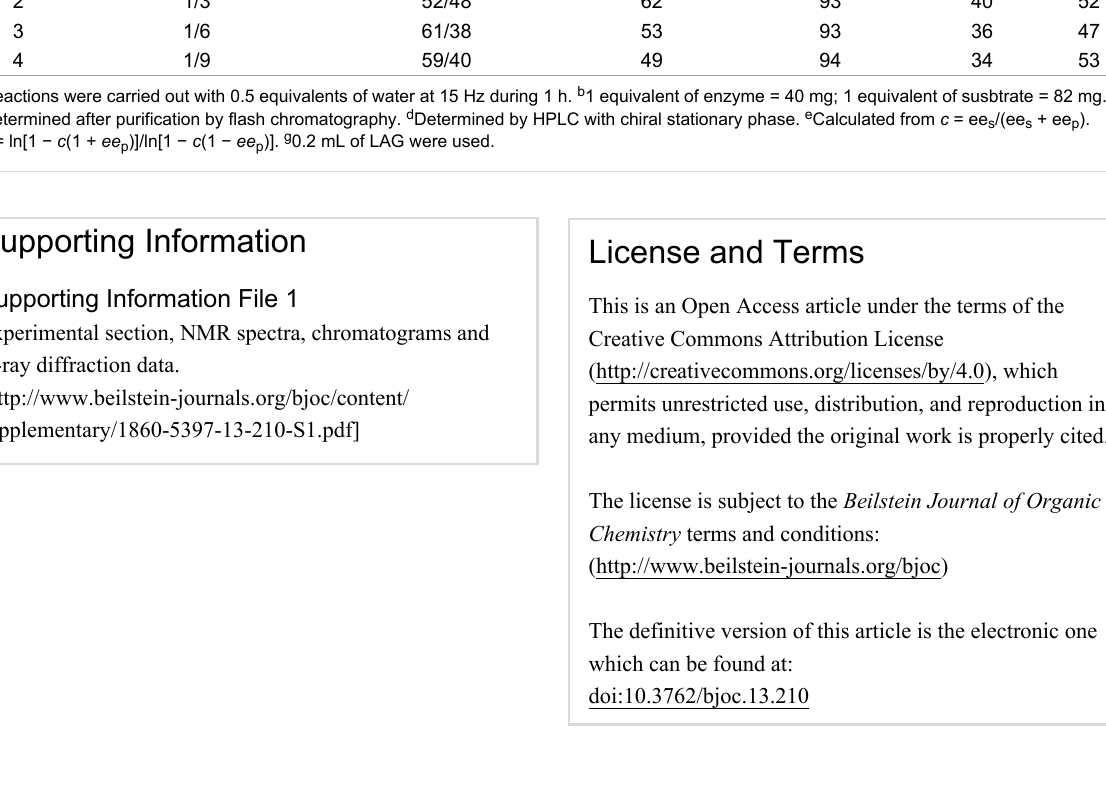
entry a catalyst/substrate (equiv) b